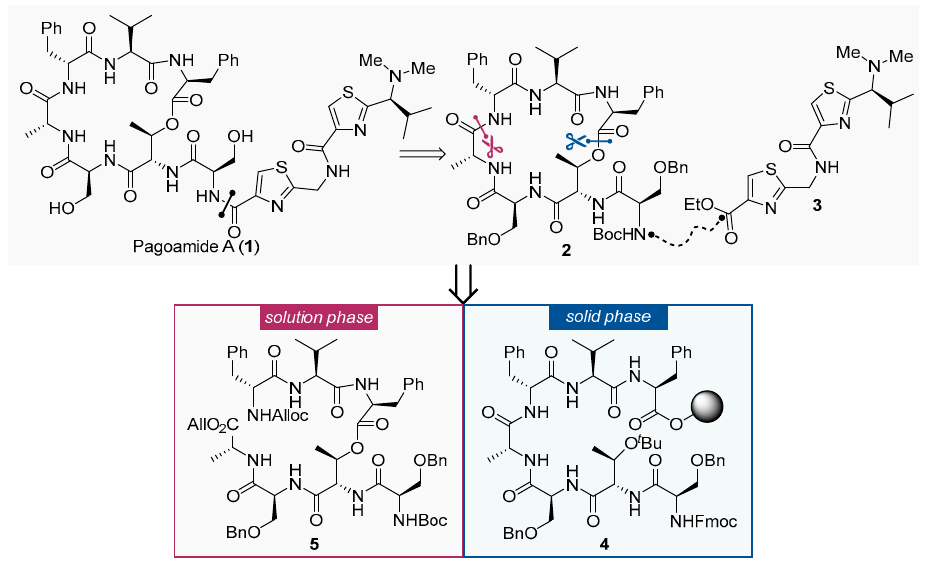
Figure 1. Structure of Pagoamide A ( 1 ) and its diastereomer ( 1a